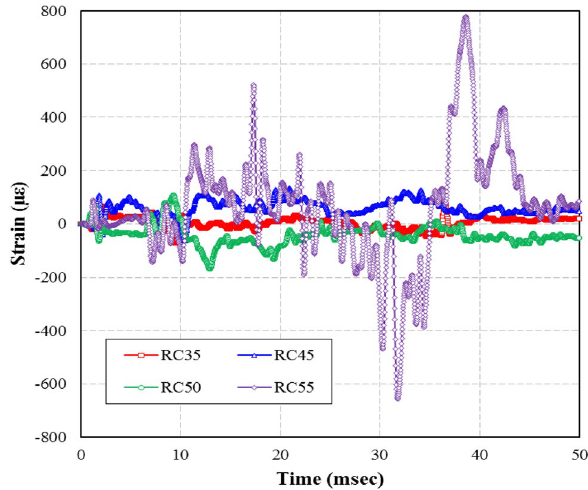
Figure 12. Concrete strain results.